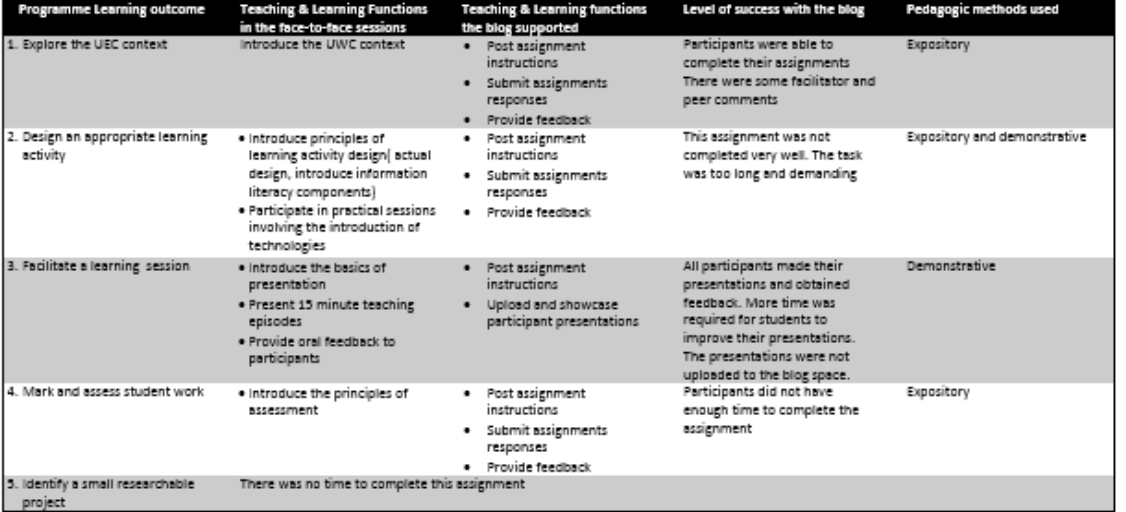
Summary of the Pedagogical Methods